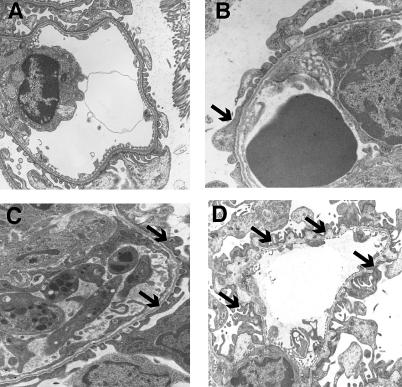
Ultra-Structural Analysis (Transmission Electron Microscopy) of GBM from Control and MMP-Inhibitor–Treated Mice(A) Control C57Bl/6 mice at 14 wk of age. The 5-wk-old normal mice also exhibited normal GBM architecture (unpublished data).(B) Kidneys from 5-wk-old
α3(IV)
−/− mice before the onset of proteinuria, displaying the beginning of splitting of the GBM and podocyte effacement (arrow).
(C). Kidneys from
α3(IV)
−/− mice at 14 wk of age, which were treated from 5 wk of age with MMP-inhibitors for 9 wk, displayed moderate GBM-splitting and podocyte effacement (arrows).
(D) Kidneys from 12-wk-old
α3(IV)
−/− mice without treatment showed severe lesions of the GBM associated with podocyte effacement (arrows). Original magnification: ×12,250.